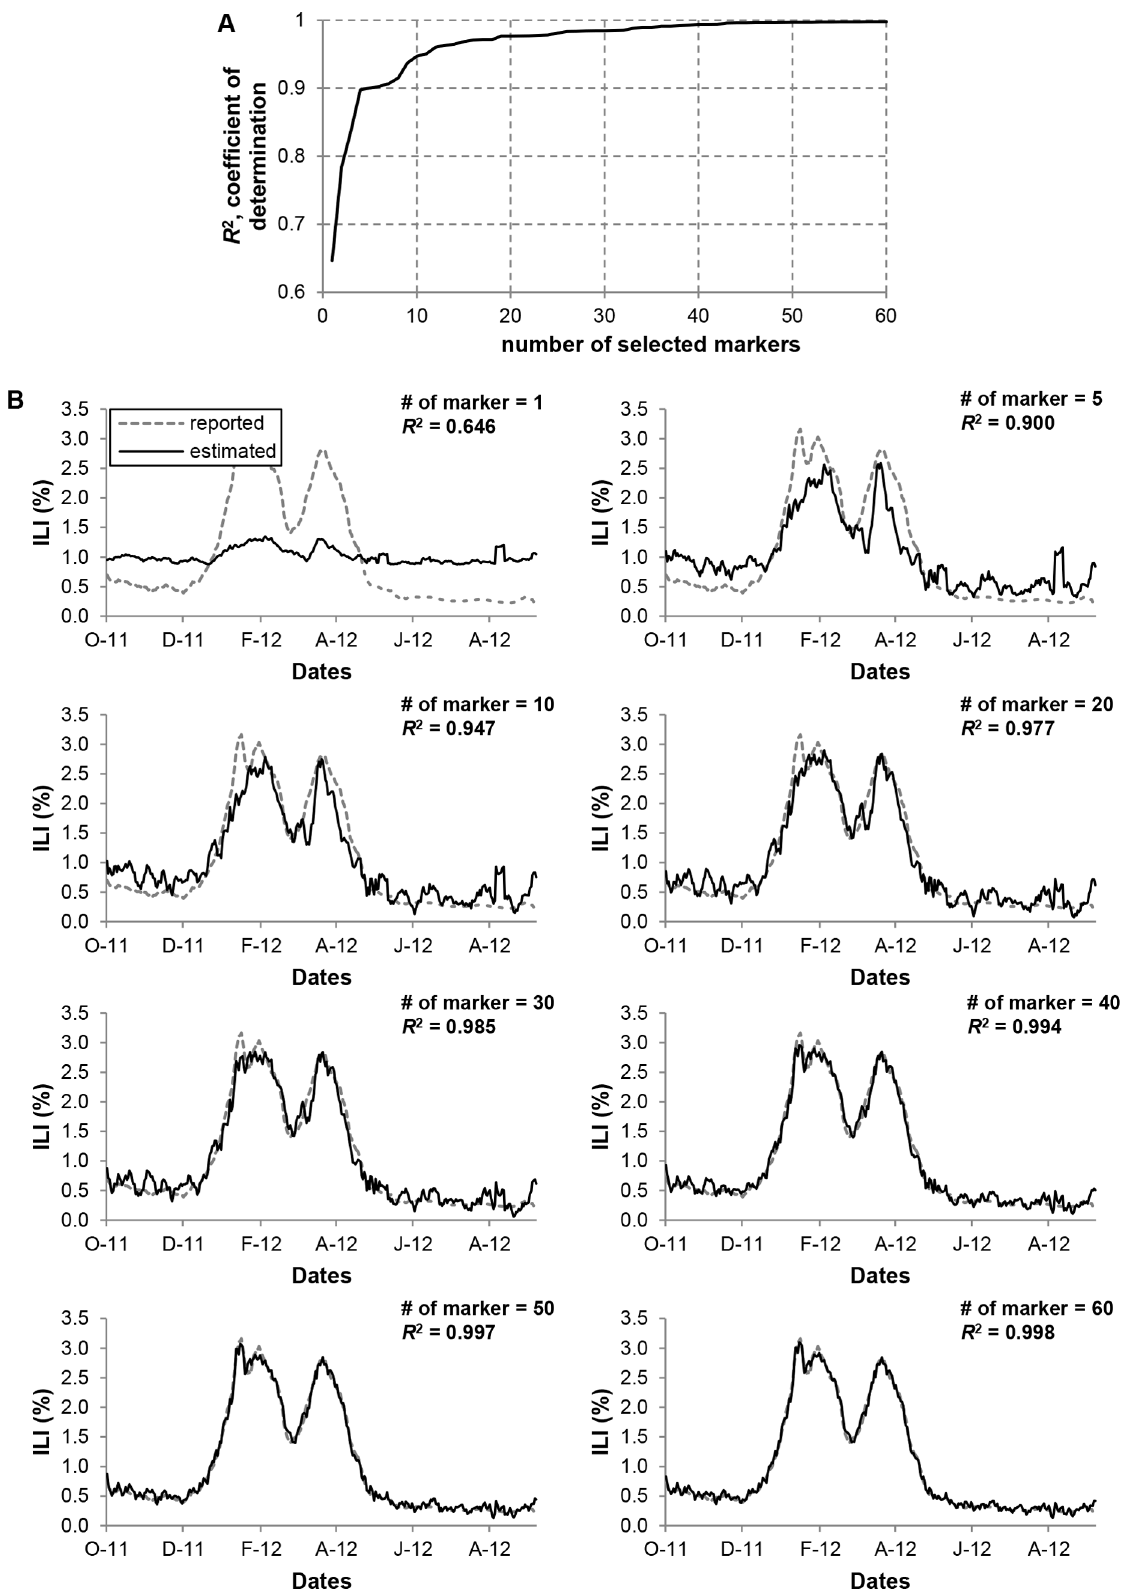
Figure 4. Cross-correlation among the markers. A) The effect of reducing number of markers. R 2 is plotted as a function of number of markers. B) Comparison of y and ^ yy . The improvement of the estimation becomes less significant when M S is increased beyond 40.